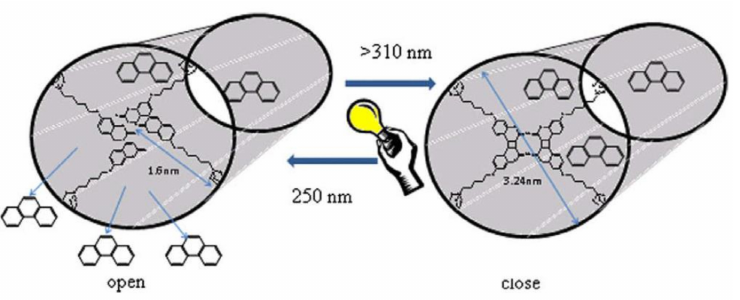
Figure 44. The concept of the photocontrolled “open-close” mechanism. Reprinted from [42], Copyright (2010), with permission from Elsevier.